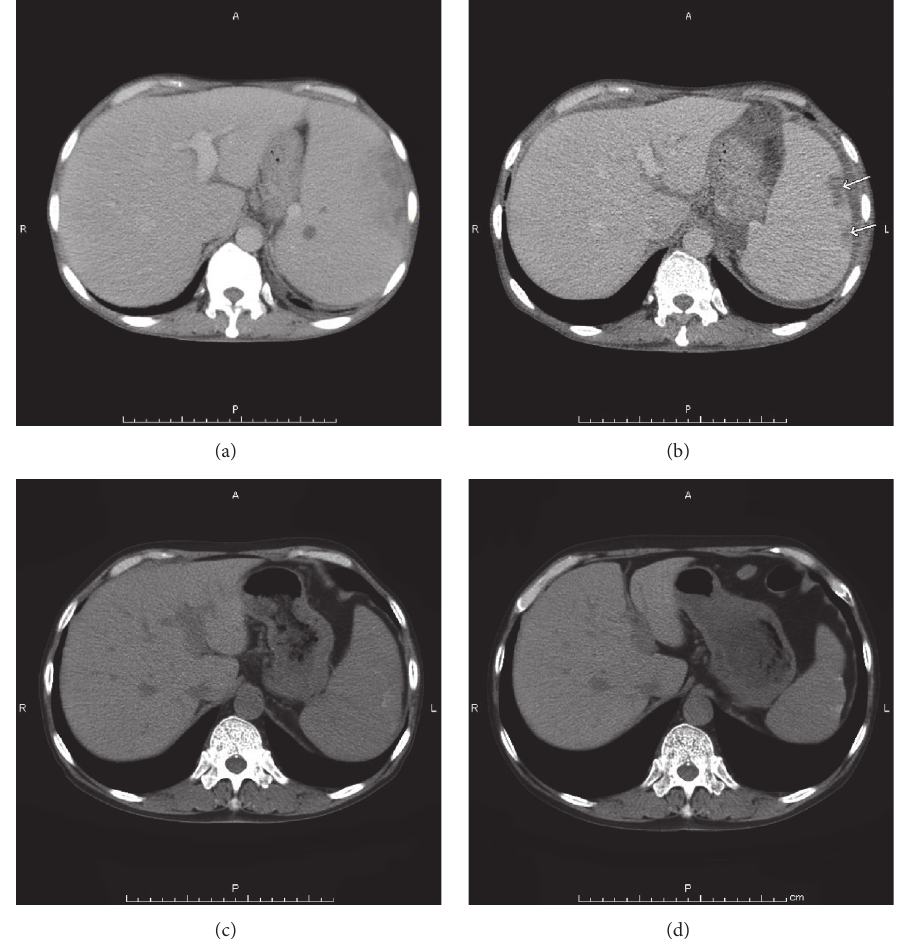
Figure 1: Case 1. Computed tomography (CT). (a) Before HCT, the CT showed severe splenomegaly. (b, c, d) After HCT, the massive splenomegaly was gradually reduced. (b) Three months. (c) Six months. (d) Twelve months. The arrow shows